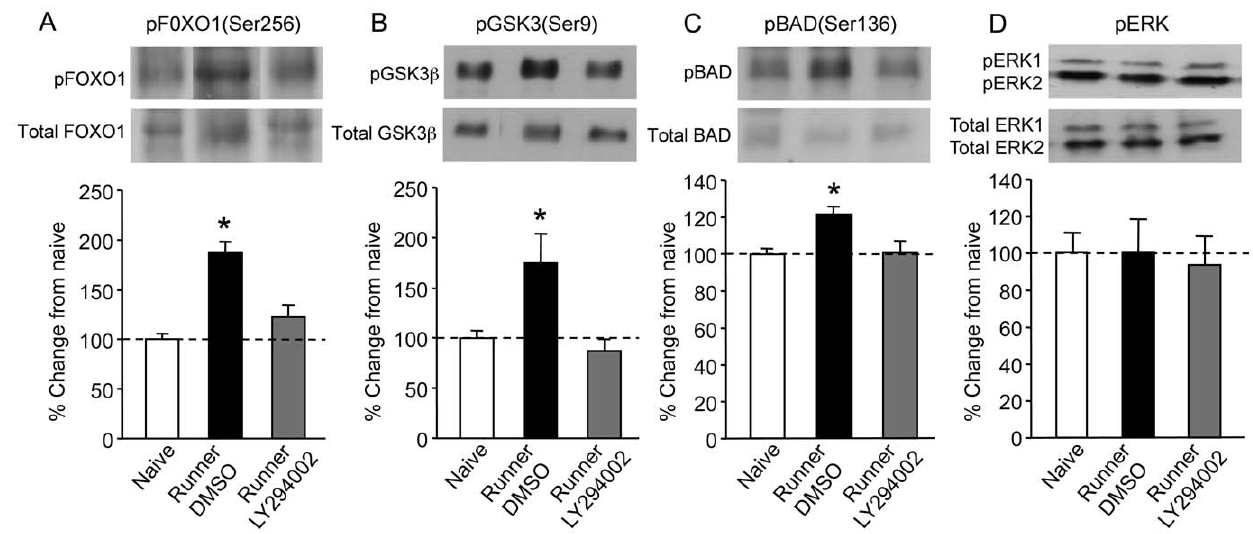
Figure 3. Regulation of downstream target proteins of Akt in the dentate gyrus following exercise. A, Phosphorylation of FOXO1(Ser256), B, GSK3 b (Ser9), and C, BAD(Ser136) in the three groups (n=4 per group). For all three proteins, DMSO-treated runners (Black bars) showed a significantly greater level of phosphorylation of the three Akt target proteins than either the naı¨ve rats (White bars) or LY294002-treated runners (Grey bars). LY294002-treated runners show no significant increase in phosphoprotein levels compared with naı¨ve rats, although there was a slight increase in pFOXO1. 3D. Exercise does not lead to phosphorylation of ERK. DMSO-treated runners (Black bars, n=4) show no difference in phosphoERK levels compared with naı¨ve rats (White bars, n=4). Neither does inhibition of PI3 kinase effect levels of ERK, as there is no difference between LY294002-treated runners (Grey bars, n=4) and DMSO-treated runners or naı¨ve rats. Sample blots for each group are represented in the upper panel.